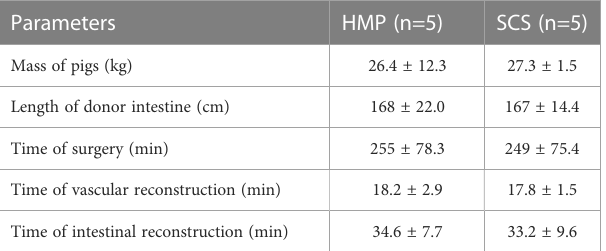
TABLE 1 Porcine auto-transplantation surgery of intestine.